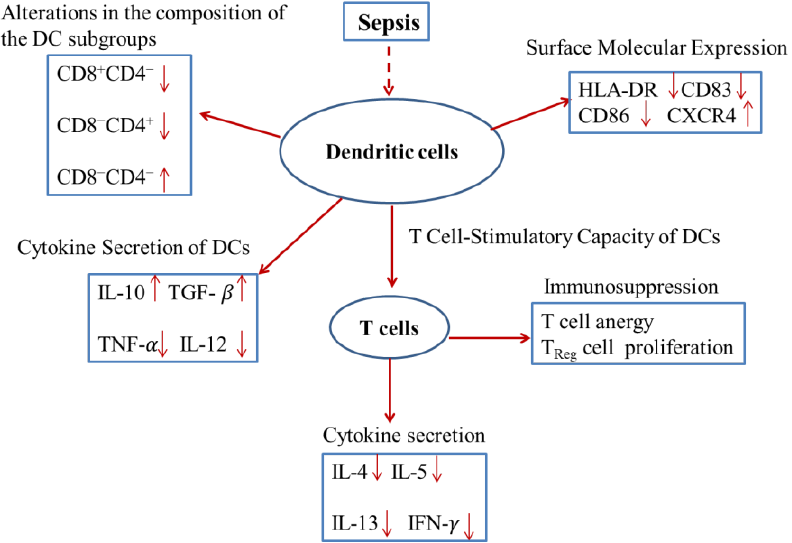
Figure 1. The surface molecules associated with dendritic cell (DC) function are changed during sepsis, and the number of DCs will be decreased, resulting from apoptosis; moreover, the secretion of cytokines in DCs will be changed, which leads to immunological tolerance.